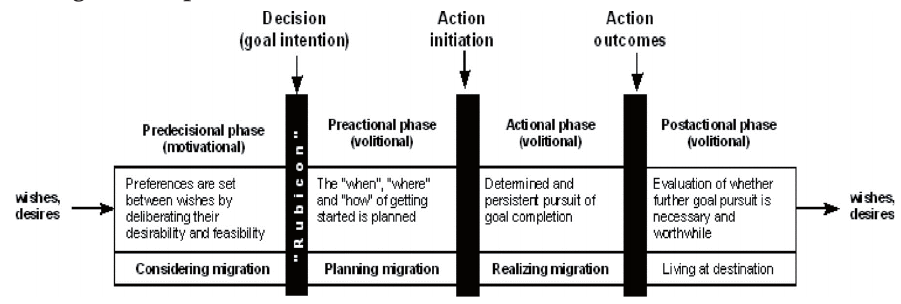
Fig. 2.: Four phases of Rubicon